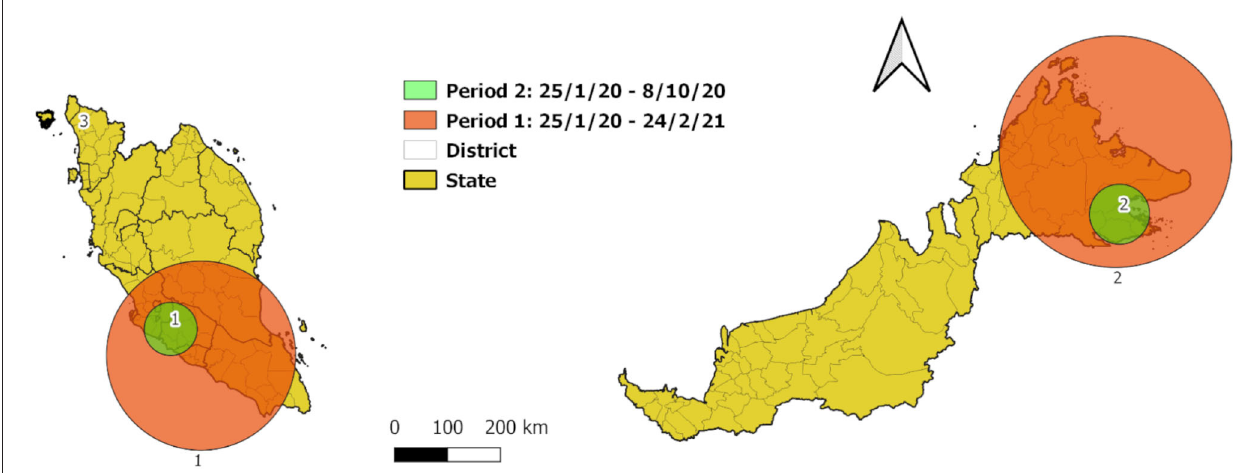
FIGURE 6 | Spatial scan statistic of COVID-19 new cases by district in Malaysia at cumulative sum of current and 7 days retrospectively from January 25, 2020 to February 24, 2021.